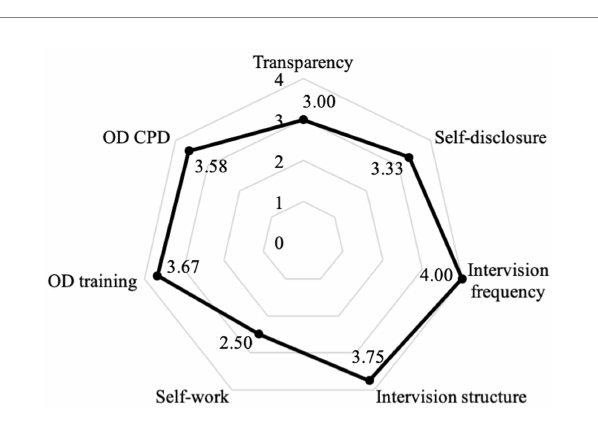
FIGURE 4 Mean scores of the Open Dialogue (OD) addendum (Open Dialogue teams). CPD=Continued professional